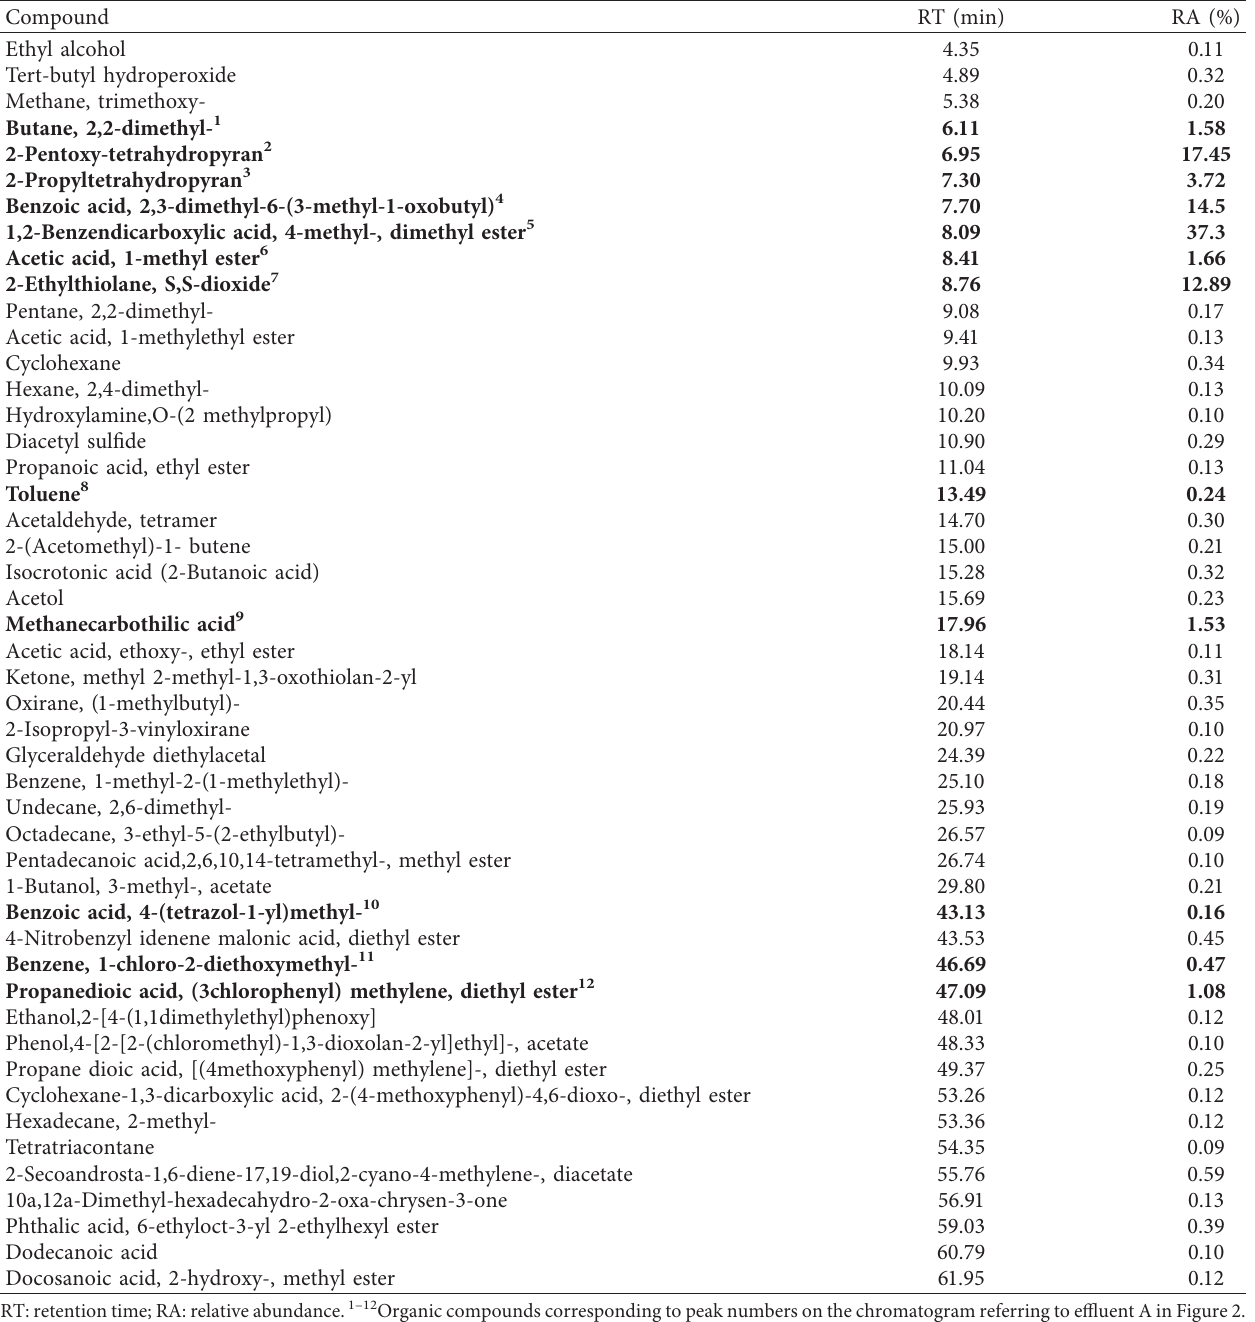
Table 2: Organic compounds identified in real textile effluent